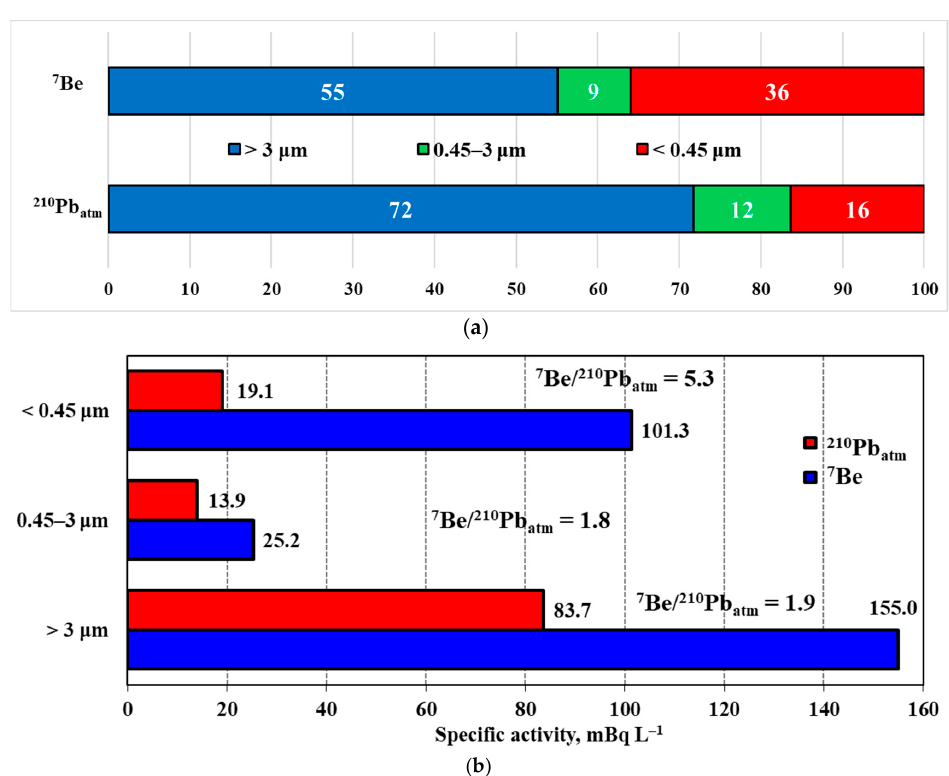
Figure 12. Averaged values of the particulate fractions contribution (%) to the total activity ( a ) and specific activities ( b ) of 210 Pb atm and 7 Be in suspended matter in the snow water of Group 1 samples.